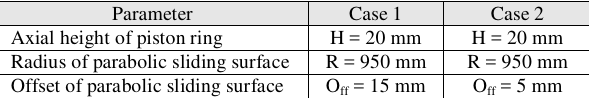
Table 4. Basic geometric parameters of the 1st (top) piston ring Parameter Case